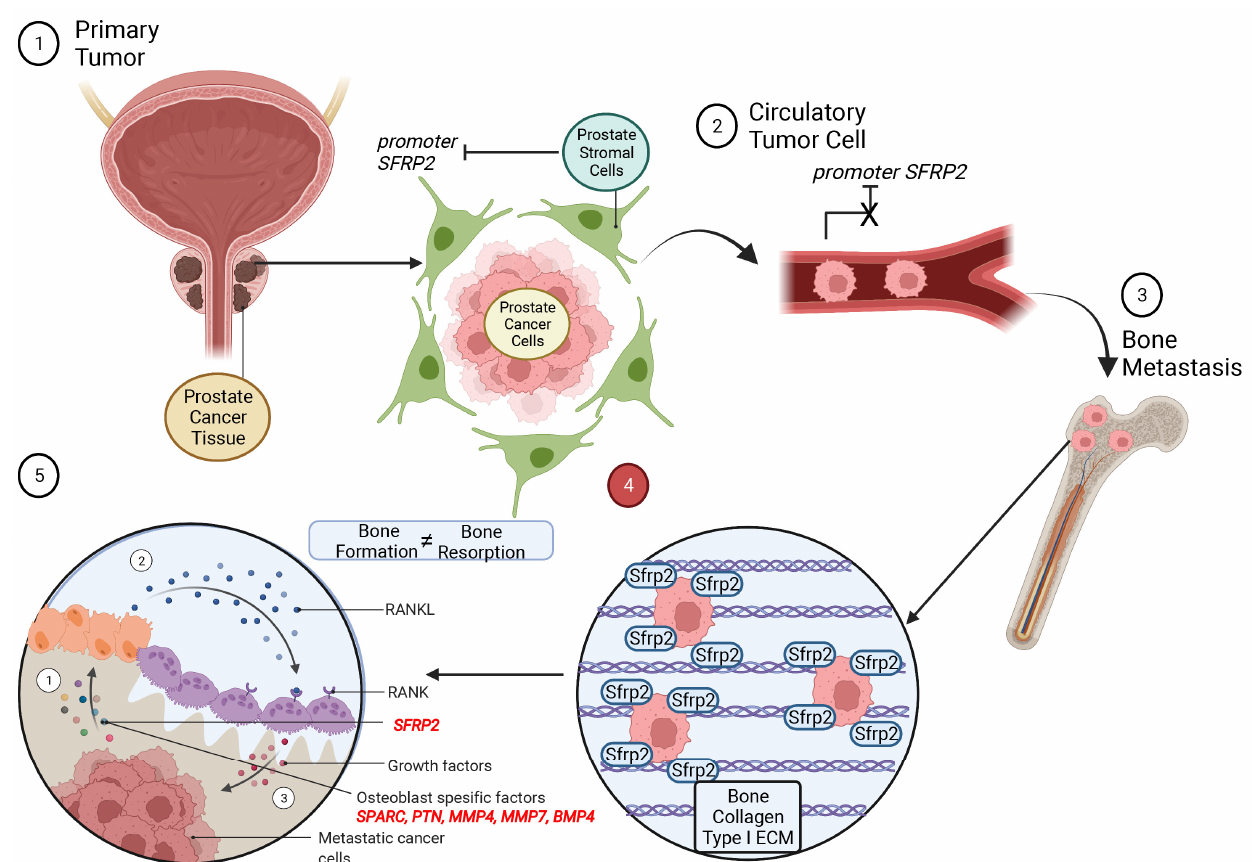
Figure 7. Visual representation of the potential effect of SFRP2 on prostate cancer cells during bone metastasis. After prostate cancer cells enter the circulation, SFRP2 expression leads them to attach and invade bone. PC3 SFRP2 cells start to secrete osteoblast-specific factors for osteomimicry and dis- turb the balance between bone formation and resorption. Created with BioRender.com (accessed on 14 June 2022, adapted from “Metastasis to Bone Disrupts Bone Homeostasis”).